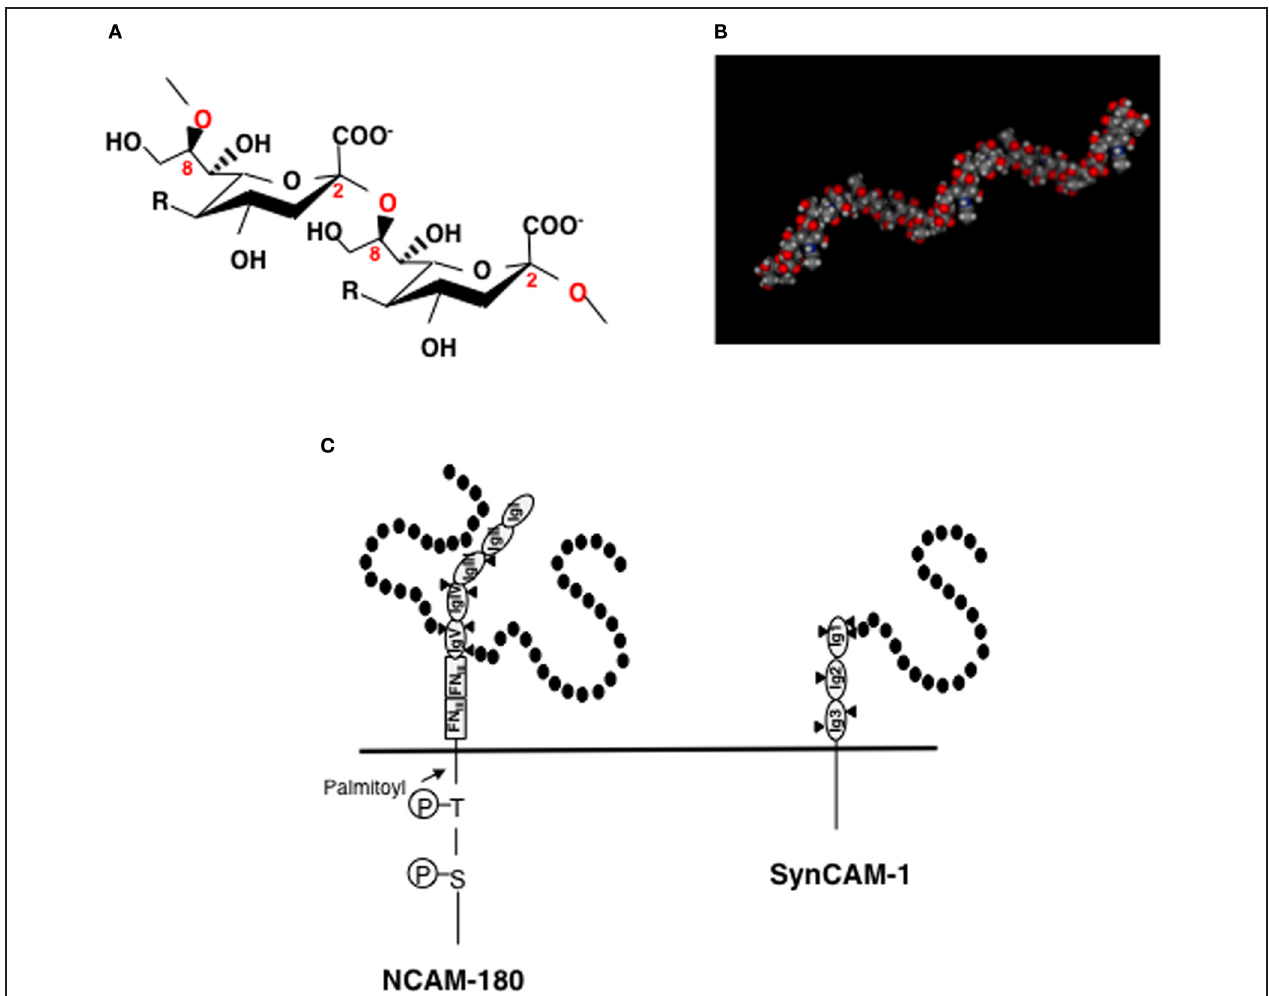
FIGURE 1 | Structures of polySia, polySia-NCAM, and polySia-synCAM. (A) α 2-8linked polySia structure. R = -NHCOCH 3 , Neu5Ac; -NHCOCH 2 OH, Neu5Gc, -OH, KDN. In the brain, polySia is polyNeu5Ac. (B) Molecular modeling of polySia (DP = 12). The polySia structure is linked to Gal at the C3-position. Calculated α 2,8-linked dodecaNeu5Ac-Gal structure is shown as space-filling models. The MOE program was used for the construction and calculation of the energies of α 2,8-linked polySia. (C) polySia-NCAM-180 and